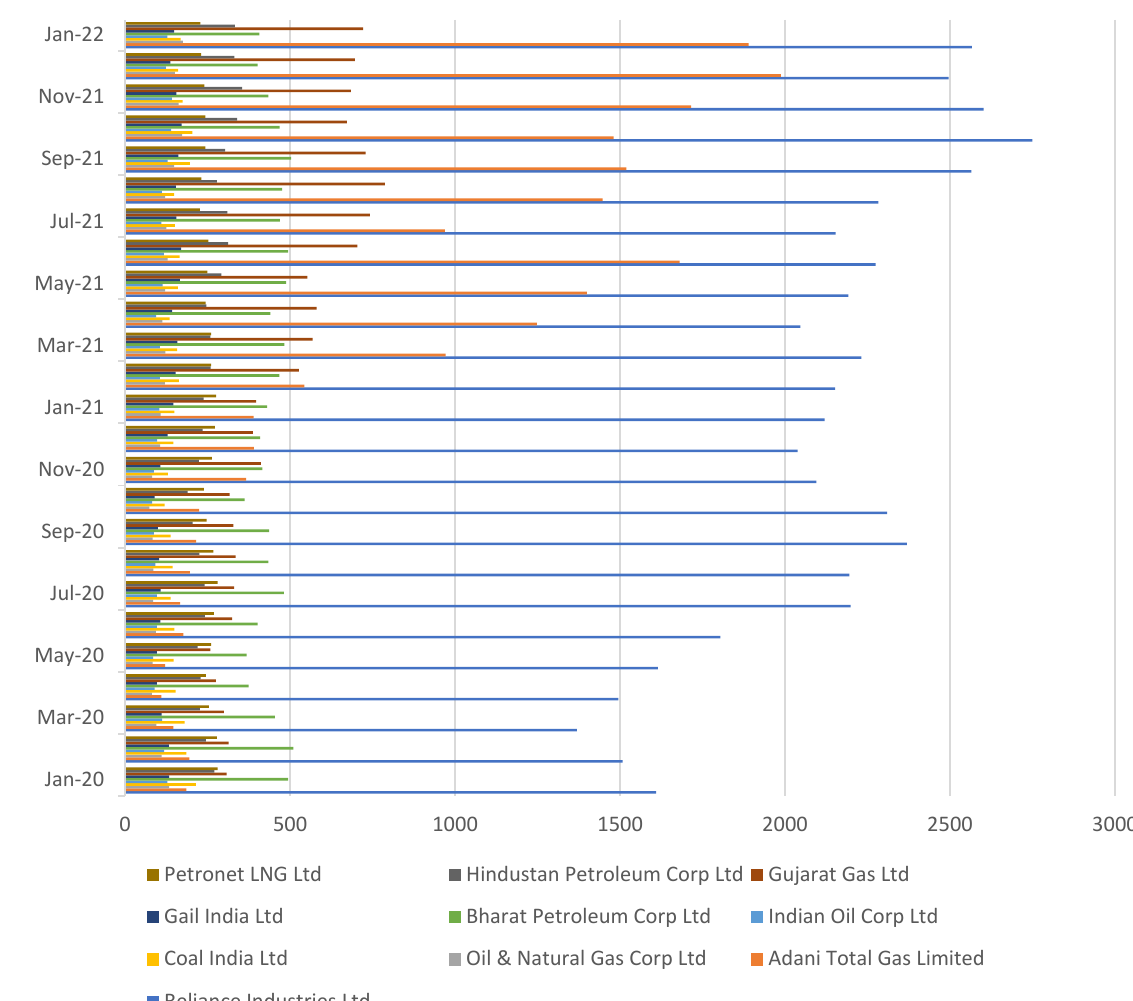
Figure 4. S&P BSE Energy Index Performance January 2020–January 2022. Source: